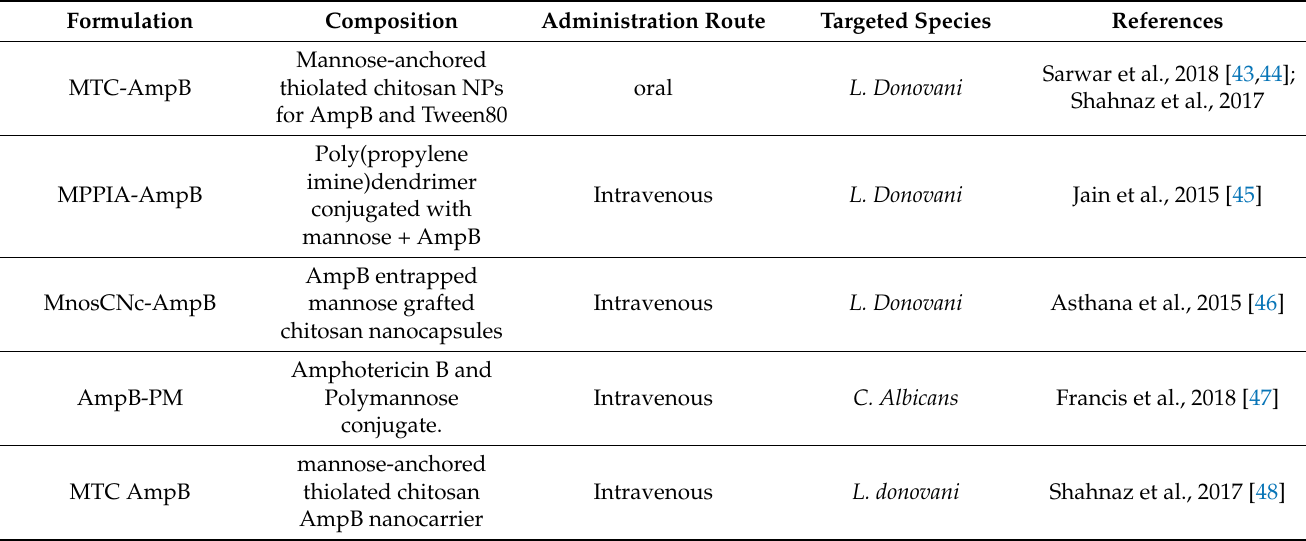
Table 4. Preclinical formulations of AmpB with macrophage targeting